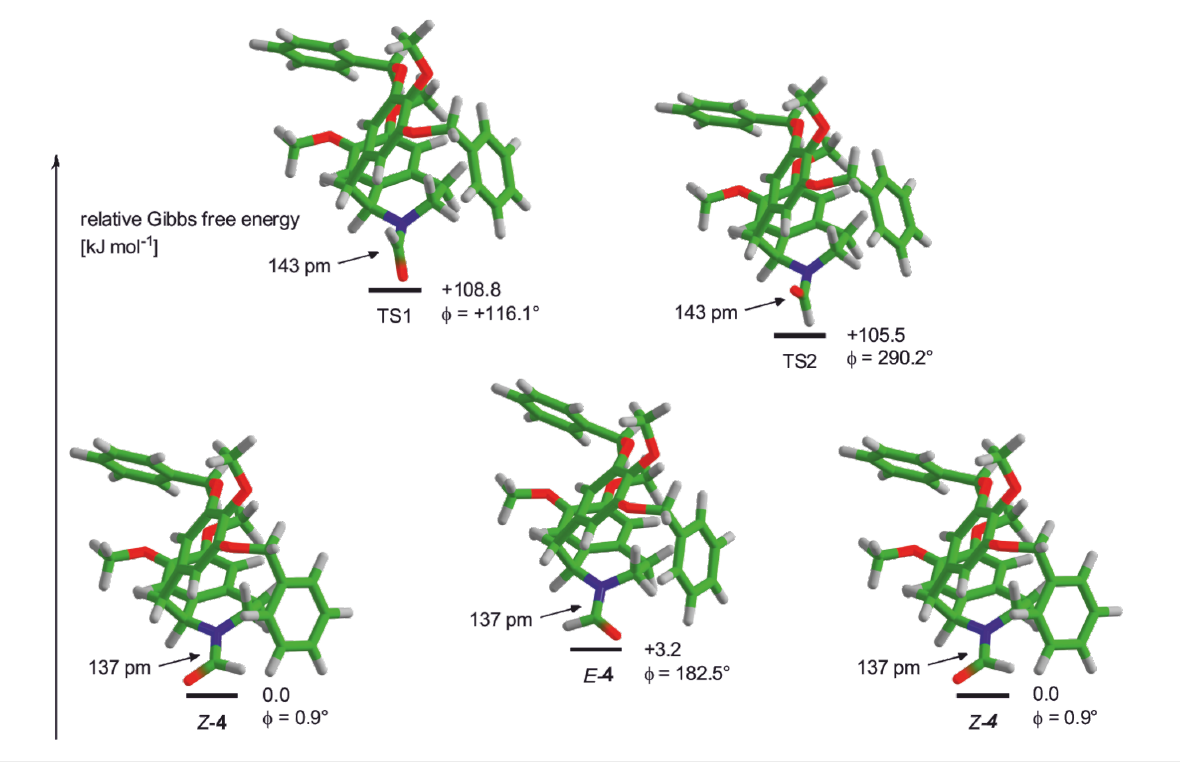
Figure 6: Energy differences and geometries for E - and Z - 4 and both transition states (TS1 and TS2) in hexane. The dihedral angle of O–C–N–C1 ( ) and the C–N bond length are given for each state